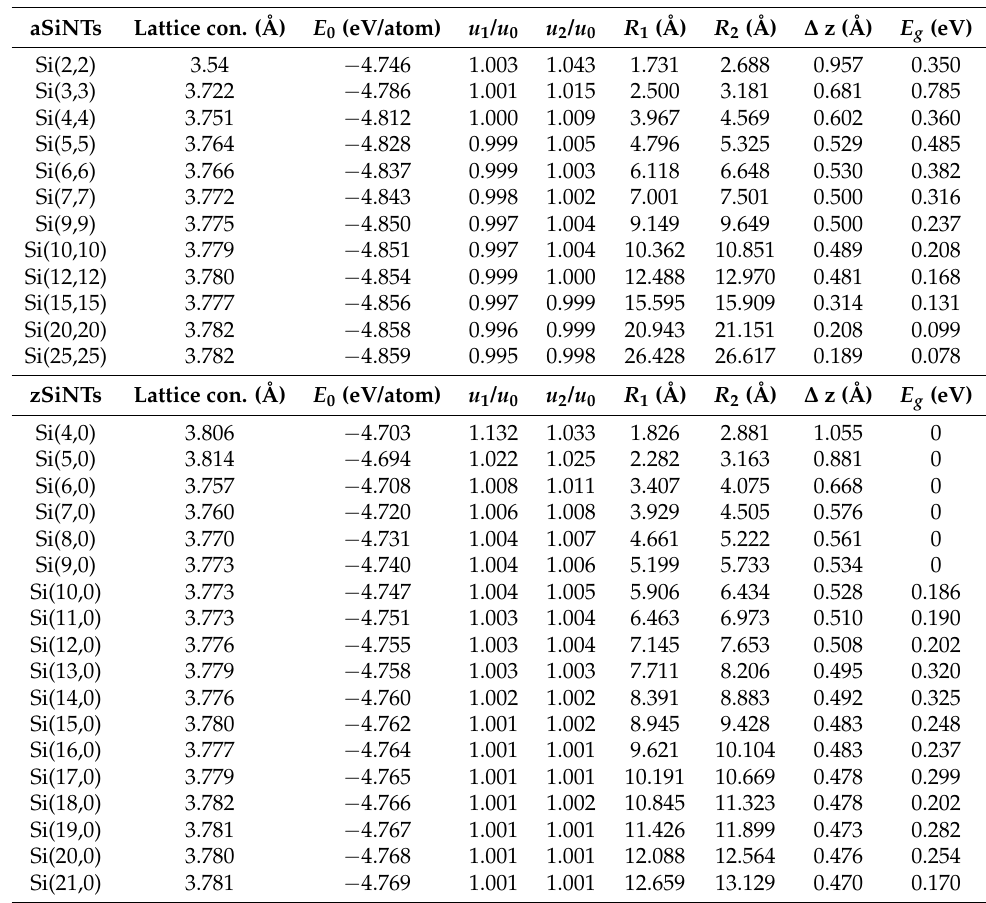
Figure 1. Cross-section and side views for ( a ) armchair (9,9) and ( b ) zigzag (9,0) SiNTs. Table 1. Geometric properties of aSiNTs and zSiNTs: lattice constant, ground state energy E 0 , Si-Si bond lengths u 1 (“perpendicular” to the axis) and u 2 (“along” the axis), radii R 1 and R 2 , buckling distance ∆ z, and band gaps E g